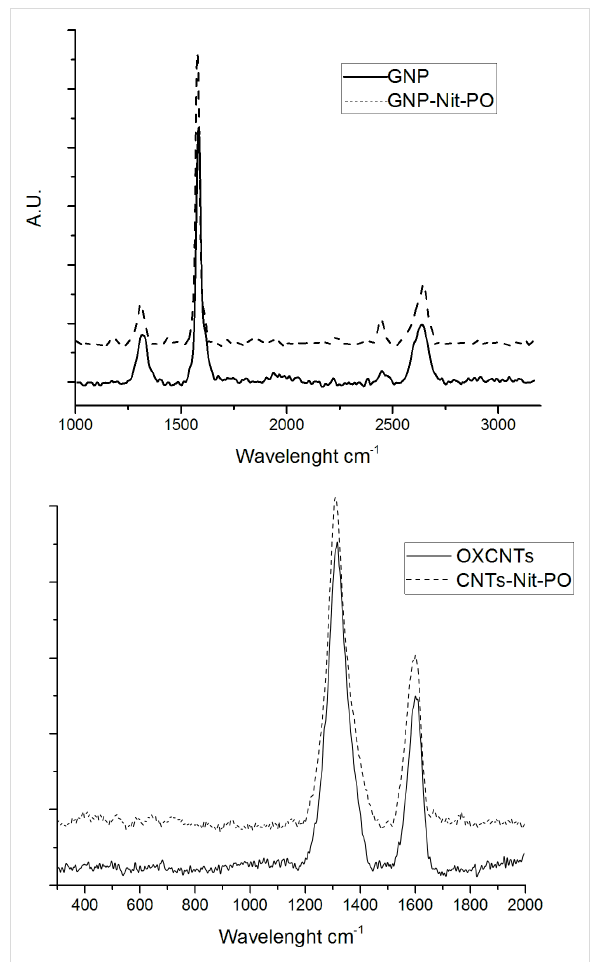
Figure 3: Raman spectra: GPs 5 vs GPs-Nit-PO 9 (top), ox-MWCNTs 4 vs ox-MWCNTs-Nit-PO 8 (bottom).